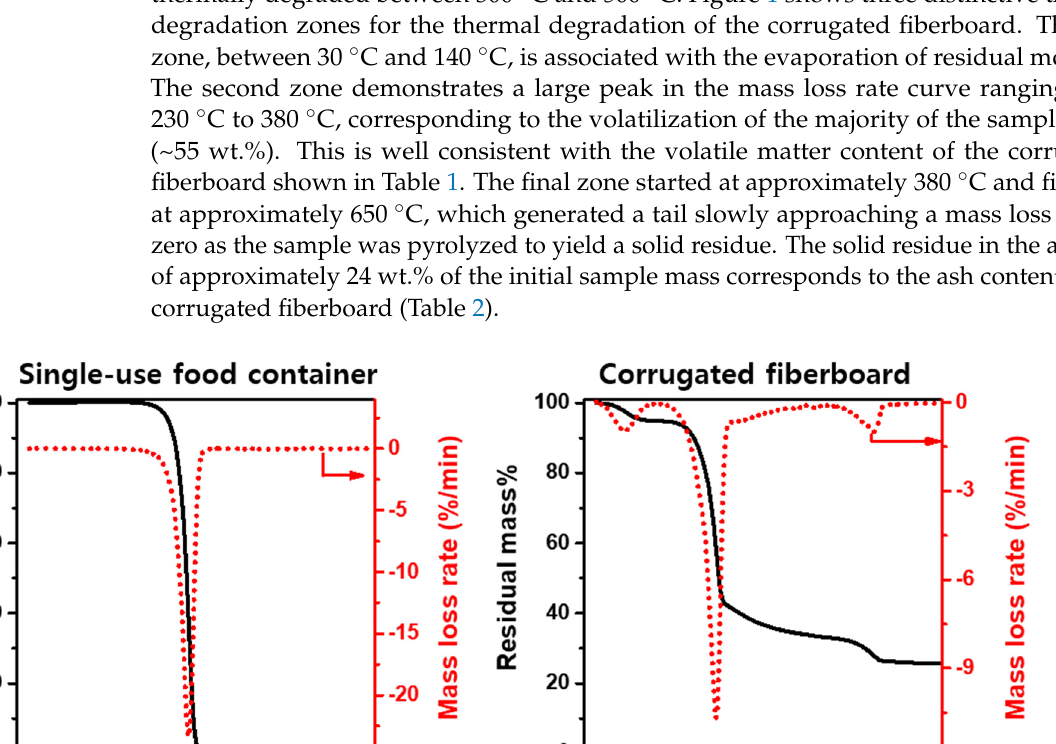
Figure 1 represents thermal mass loss and mass loss rate curves obtained via the TGA of the single-use food containers and the corrugated fiberboard. As presented in Figure 1, a single degradation zone is observed for thermal degradation of the single-use food containers, which indicates that the single-use food containers were completely thermally degraded between 300 ◦ C and 500 ◦ C. Figure 1 shows three distinctive thermal degradation zones for the thermal degradation of the corrugated fiberboard. The first zone, between 30 ◦ C and 140 ◦ C, is associated with the evaporation of residual moisture.